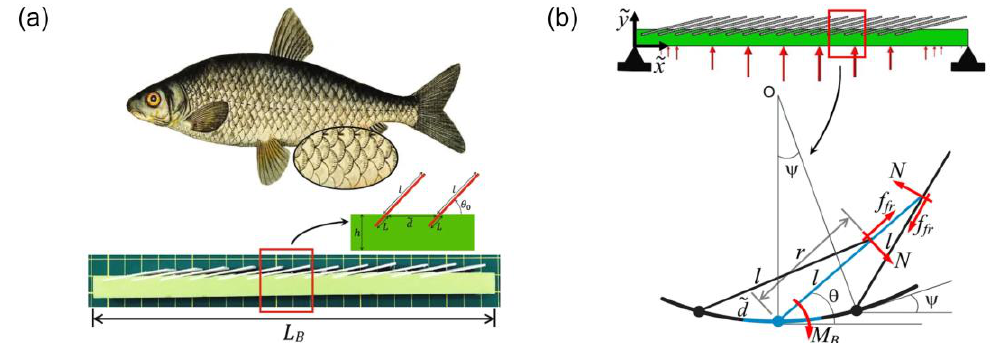
Figure 1. Analyzing fish scale model, adapted from reference [25]. ( a ) A 3D-printed fish scale, inspired from real fish scale. ( b ) Schematic of the fish scale interaction.